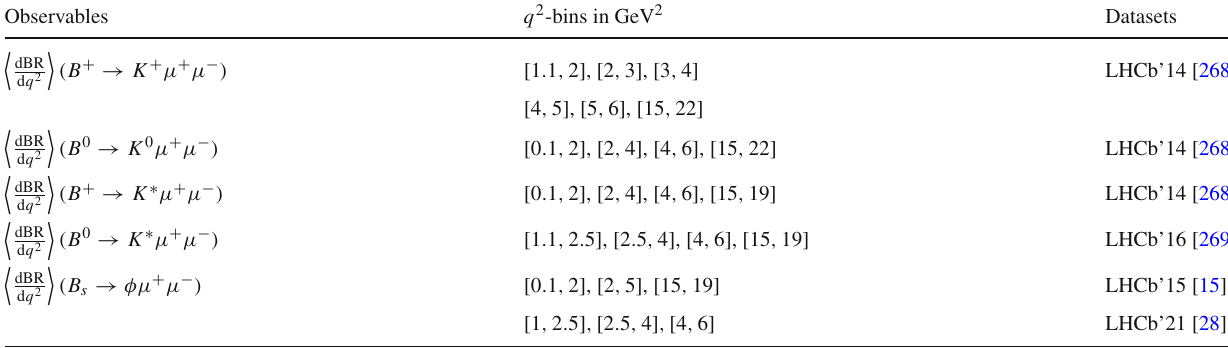
Table 7 Datasets on binned differential branching ratios in B → K ( ∗ ) μμ decays taken into account in the analysis Observables q 2 -bins in GeV 2 Datasets